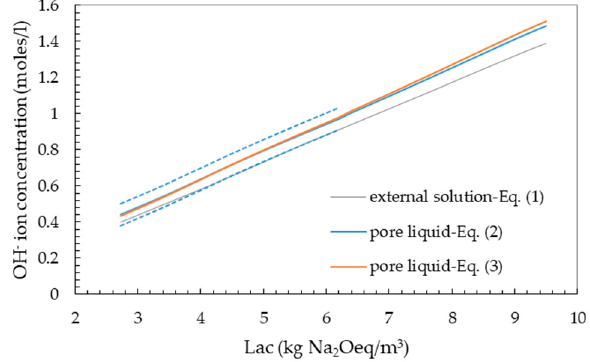
Figure 4. Comparison between the hydroxyl ion concentrations in the external solutions used in the immersion tests and those calculated for concrete pore solutions by using the empirical equations from [29] (Equation (2)) or [7] (Equation (3)).